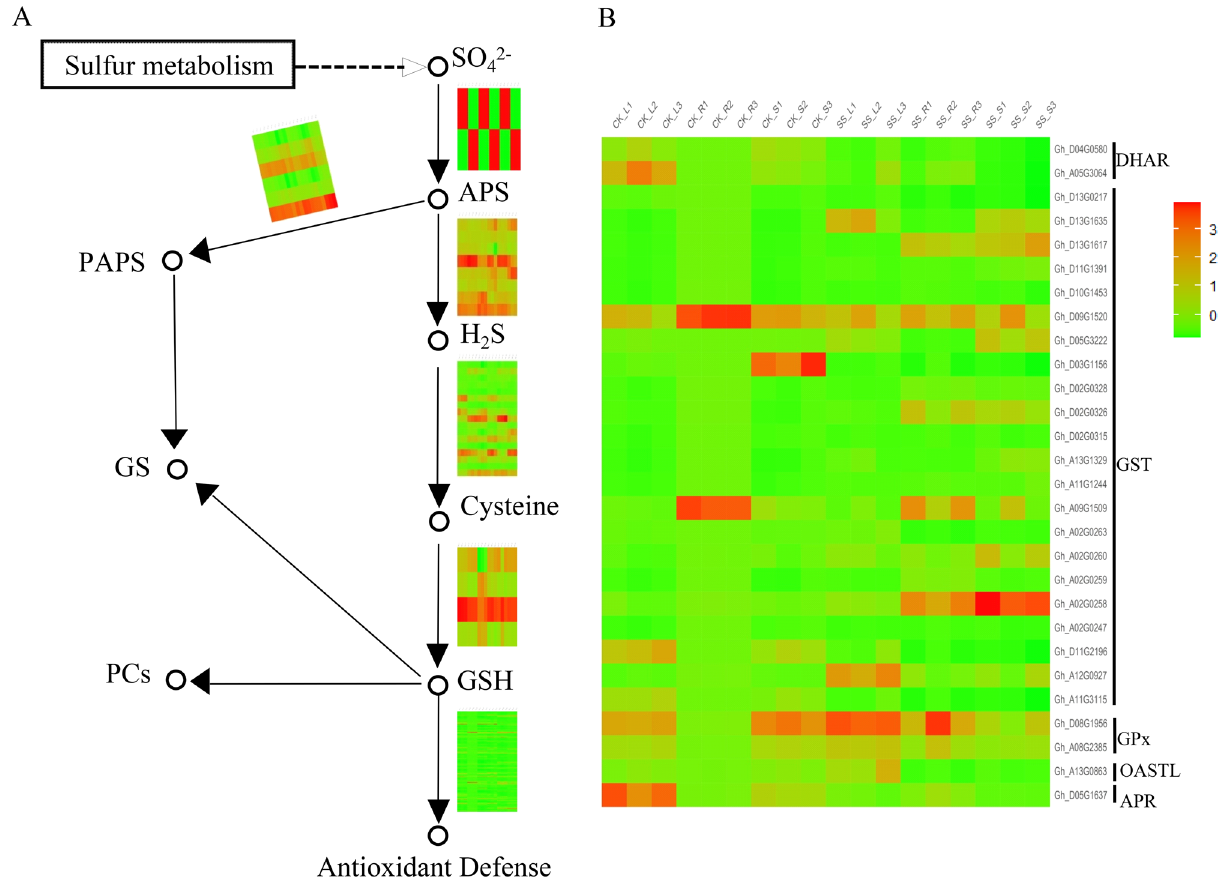
Figure 10. Analysis of differential genes in pathways of sulfur metabolism. CK: Control group; SS: 300 mM Na 2 SO 4 . (A) A schematic diagram of sulfur metabolism. Heatmap represents the expression level of regulatory enzyme gene for specific process performed by ggplot2 (v3.3.3). (B) Up-regulated DEGs and down-regulated DEGs under CK and SS performed by ggplot2